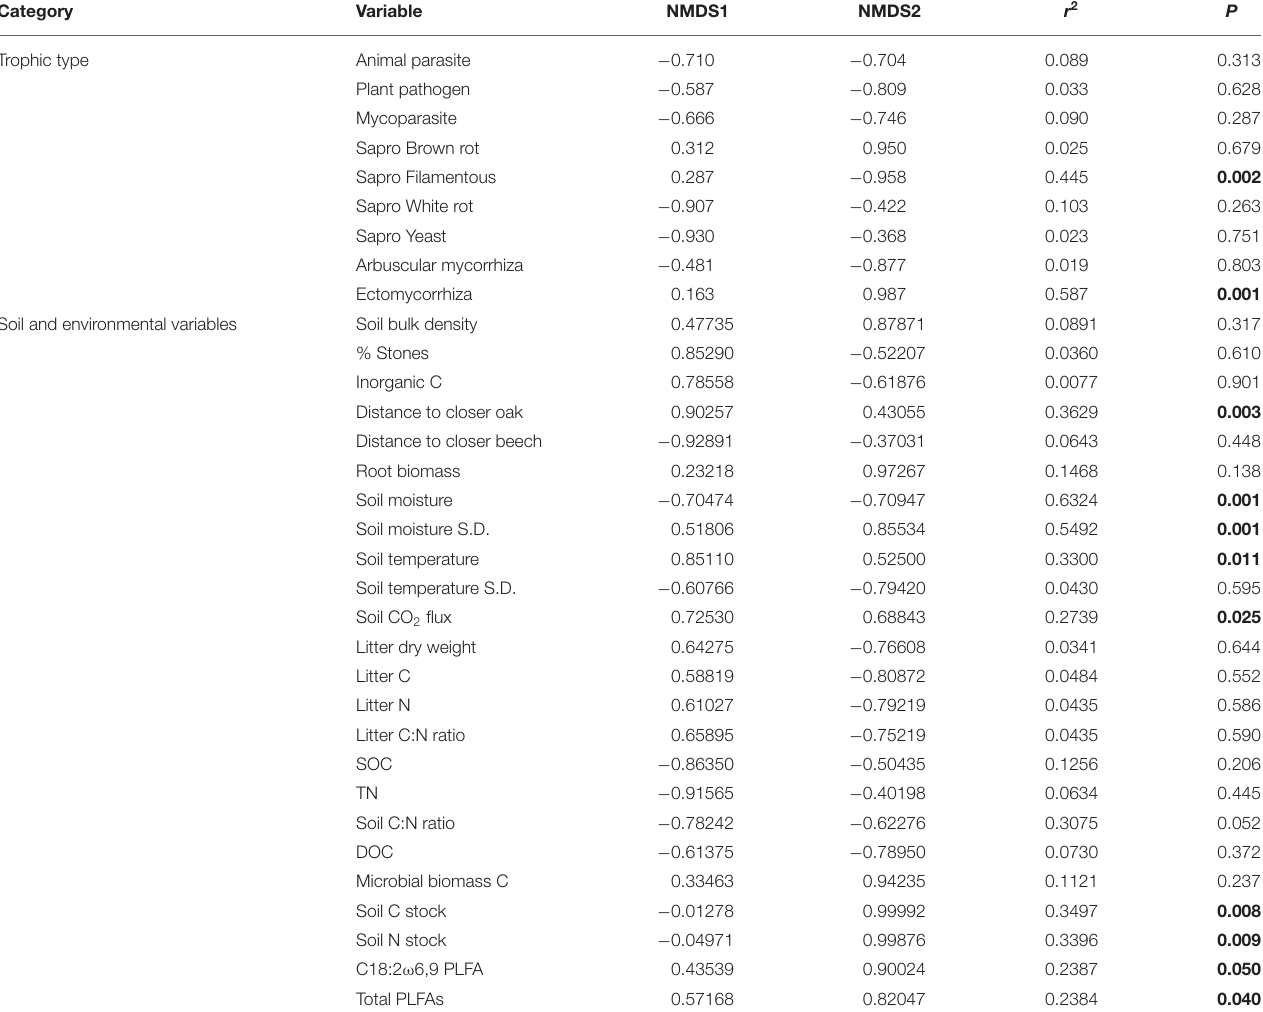
TABLE 3 | Regression weights of the variables fitted in the NMDS analysis in Figure 3c . Category Trophic